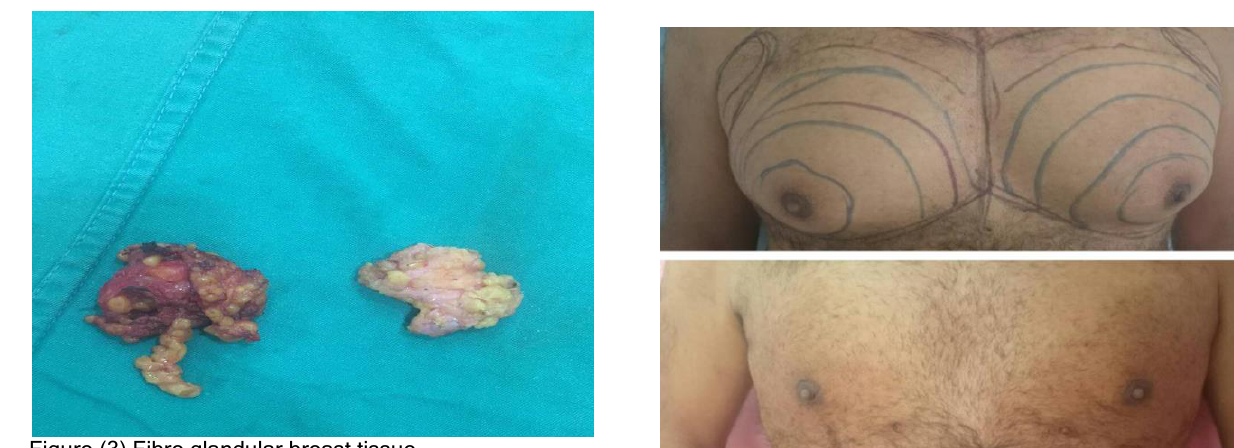
Figure (2) Periareolar approach for removal of the fibro glandular breast tissue .